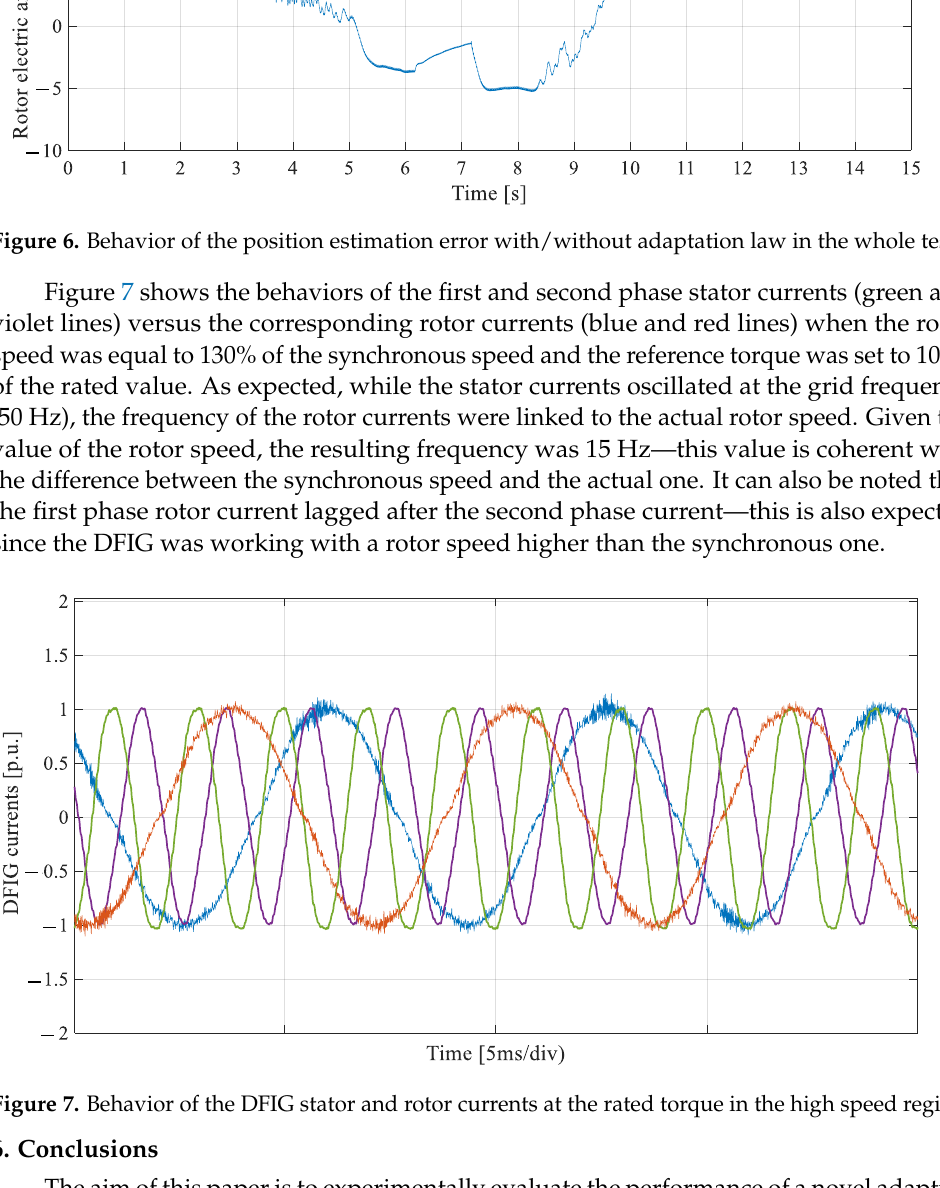
Figure 6. Behavior of the position estimation error with/without adaptation law in the whole test.